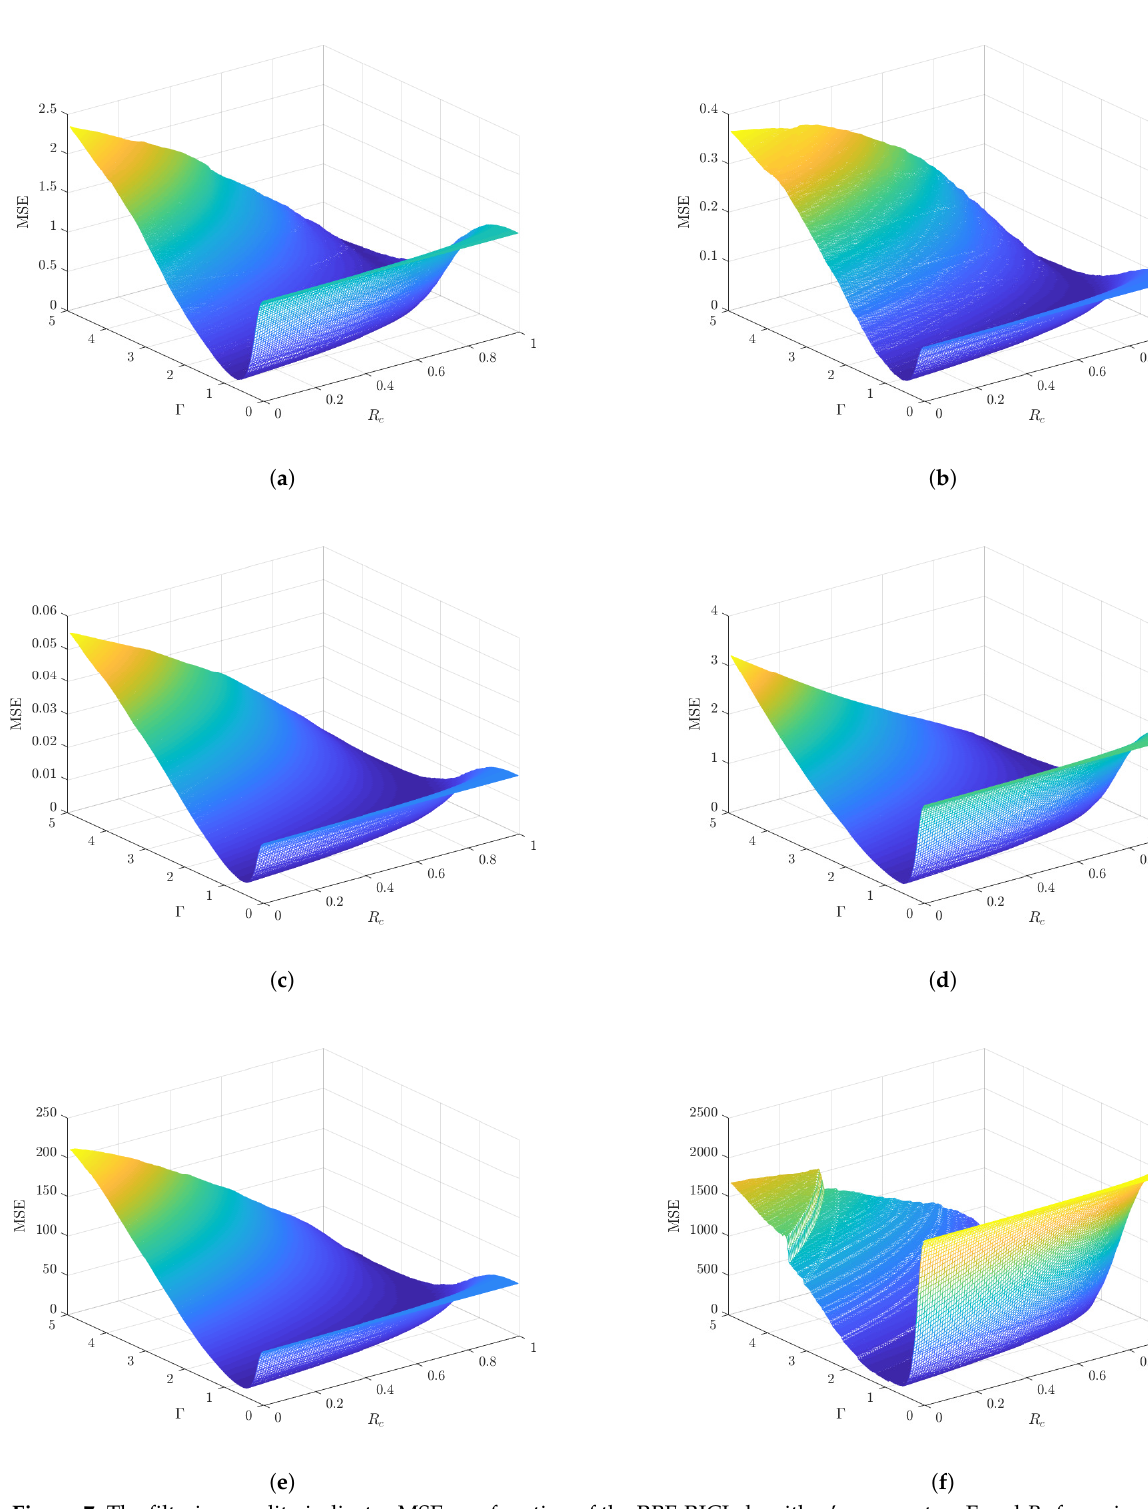
Figure 7. The filtering quality indicator MSE as a function of the RBF-RICI algorithm’s parameters Γ and R c for noisy signals at 7 dB SNR: ( a ) Blocks . ( b ) Bumps . ( c ) Doppler . ( d ) HeaviSine . ( e ) Piece-Regular . ( f ) Sing